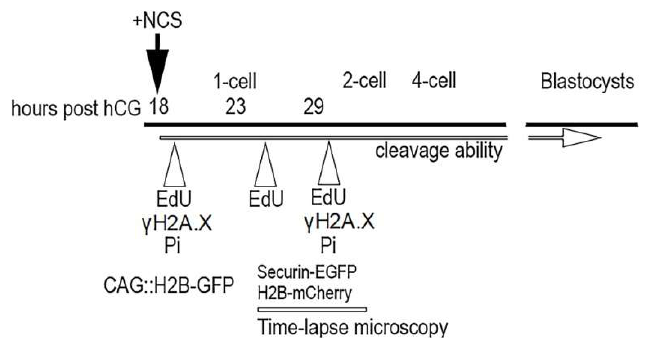
Figure 16. Experimental design. All one-cell embryos were collected at time 18 h post hCG administration and each experiment (as reported in Material and Methods) was performed separately in triplicate.